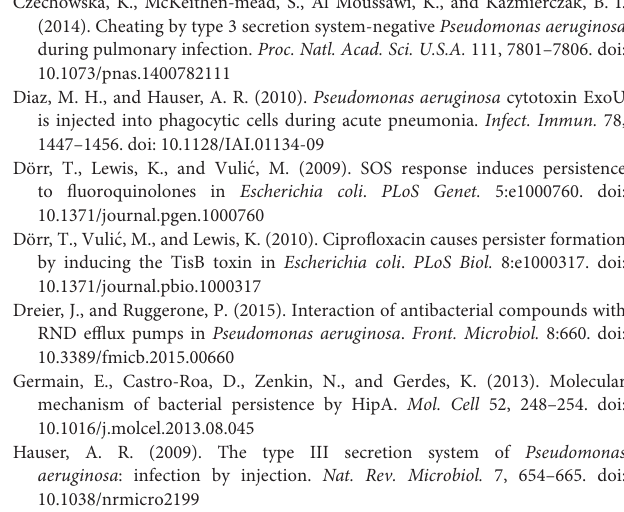
Table S1 | PA14 Transcriptome analysis: differentially regulated genes. Table S2 | Bacterial strains, plasmids and primers used in this